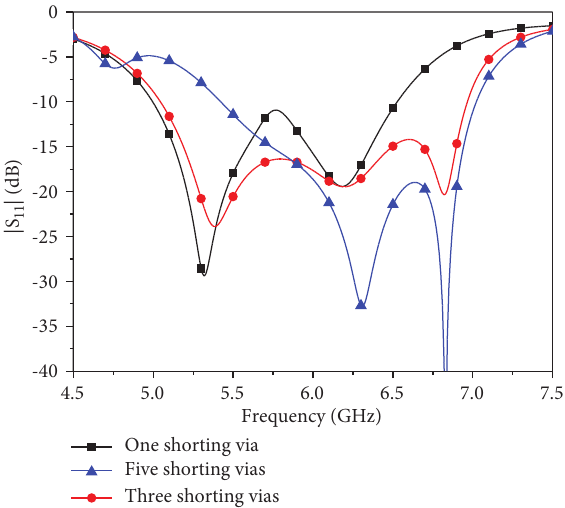
Figure 7: | S 11 | of the antenna for different numbers of vias.